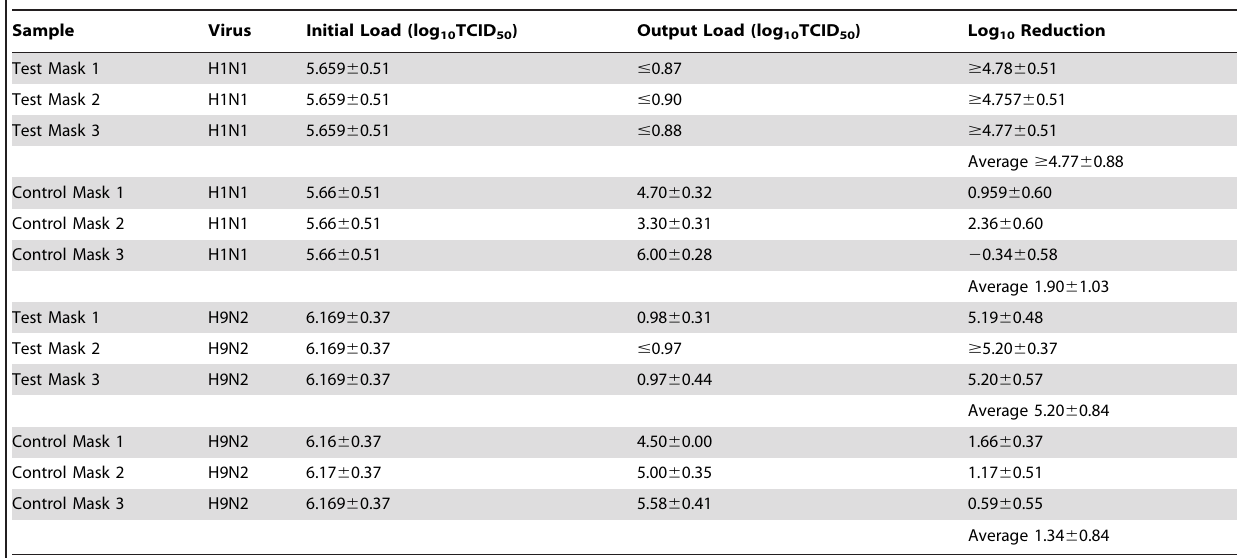
Table 2. Mask Retrieved a Infectious Titers.